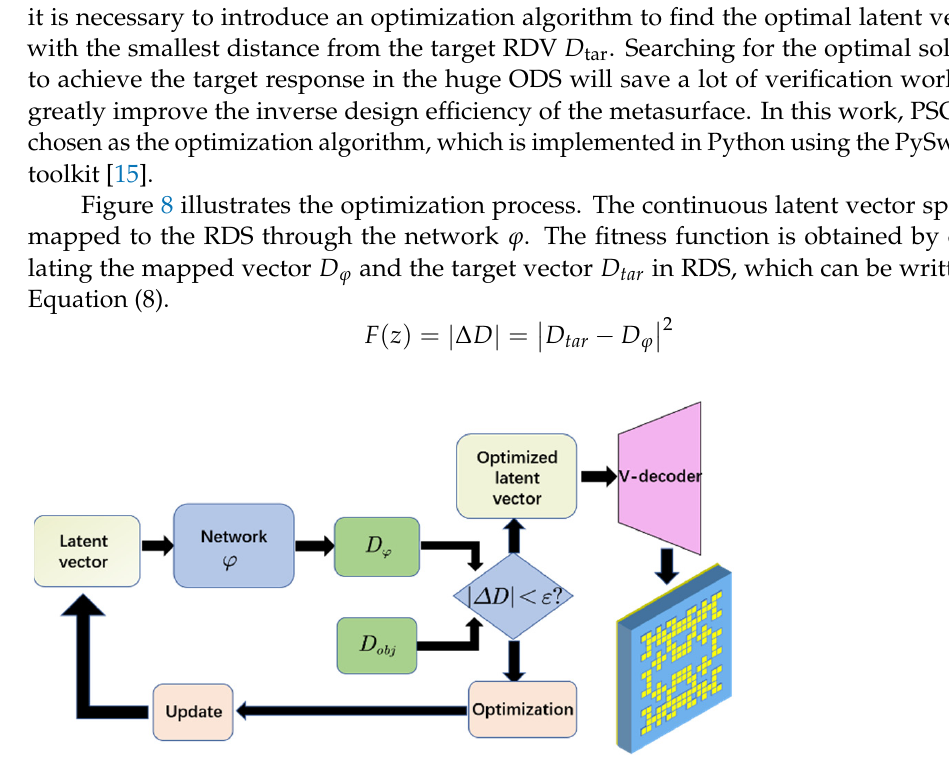
Figure 8. Flowchart of the VAE-PSO algorithm.